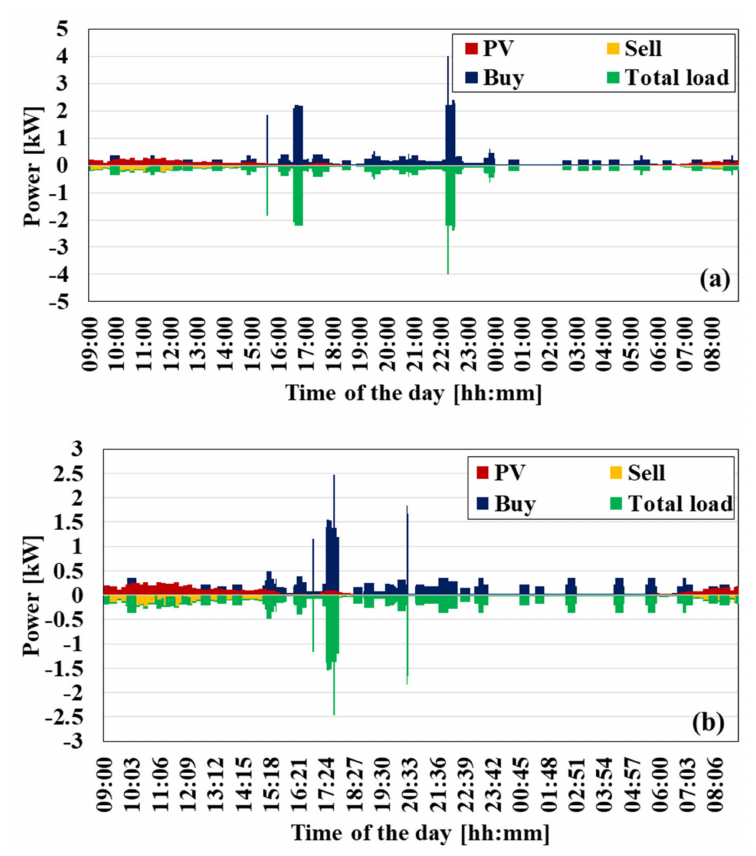
Figure 8. Power balance for dwelling25 ( a ) and dwelling27 ( b ).